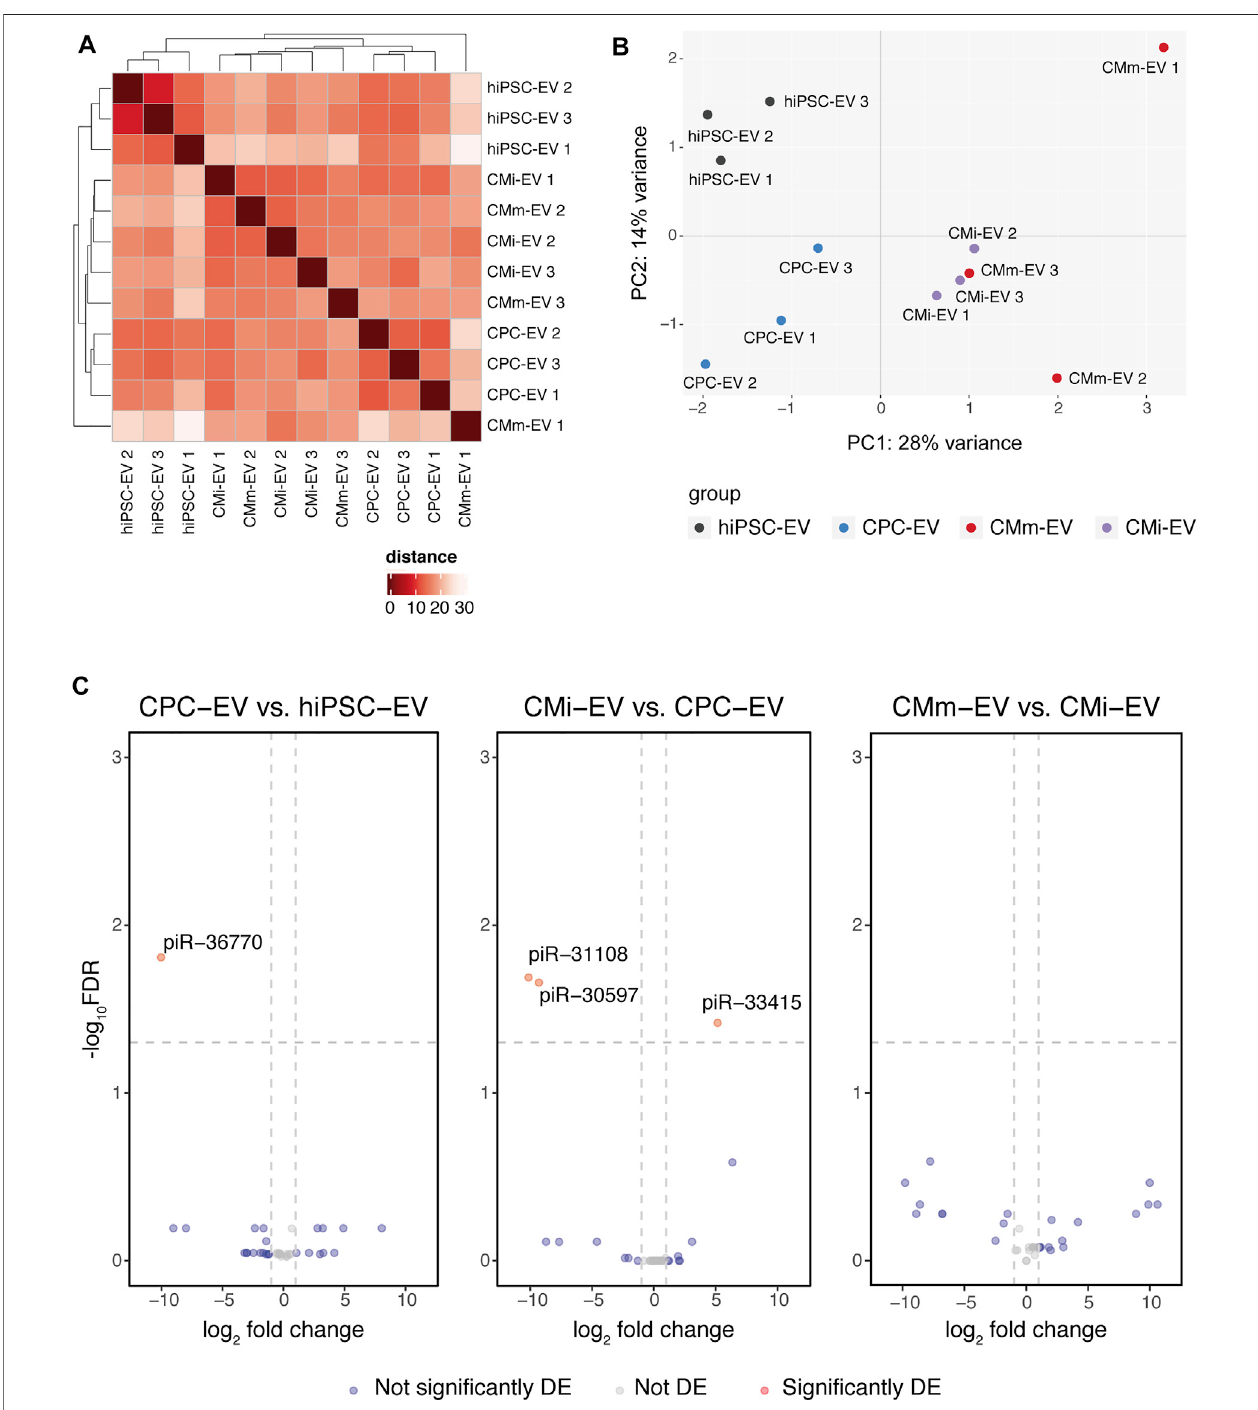
FIGURE 3 | piRNA differential expression in hiPSC-CM extracellular vesicles (EV). (A) Heatmap with hierarchical clustering of sample-to-sample distances on the matrix of log 2 TMM-normalized piRNA expression. Darker red colours indicate a more similar expression (colour key in arbitrary units). (B) Principal component analysis (PCA) performed on normalized counts. Only 42% of the variance could be explained by PC1 and PC2. (C) Volcano plots with pairwise comparisons of signi fi cantly differentially expressed piRNA between EV populations (CPC-EV vs. hiPSC-EV, CMi-EV vs. CPC-EV, CMm-EV vs. CMi-EV), with |log 2 fold change| ≥ 1 and − log 10 FDR ≥ 1.3. DE, differentially expressed.